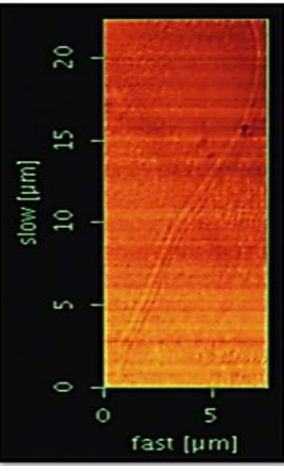
Fig. 6. AFM of DNA nanotubes filled up with an array of Fig. 4. AFM micrographs of DNT. The length and diameter of C-MNPs (black arrows). Also, a few magnetic nanoparticles DNTs show confirms the fabrication of DNATs. outside of DNA nanotubes were indicated (white arrows). In AFM image, it’s obvious the periodic array or pea-pod alignment of magnetic nanoparticles in DNTs central Figure 5 : AFM micrographs of magnetic DNTs whth extrier